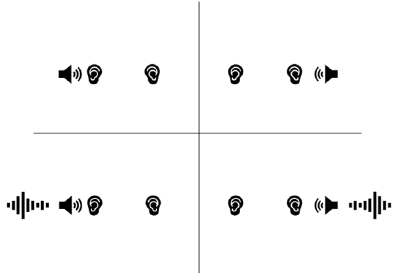
Figure 5. Schematic diagram of vocal track stimulation in each direction.